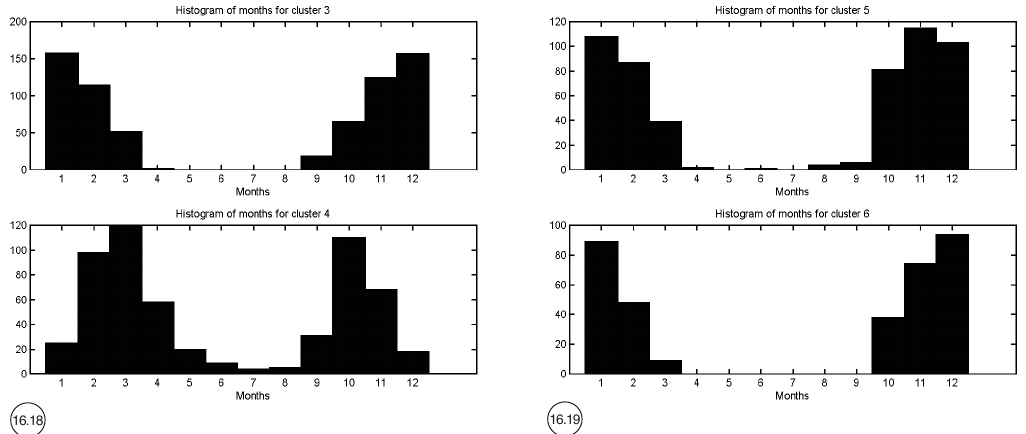
16.18 16.19 Fig. 16.18. Histogram of months (from January to December), for Cluster 3 and Cluster 4. Fig. 16.19. Histogram of months (from January to December), for Cluster 5 and Cluster 6.